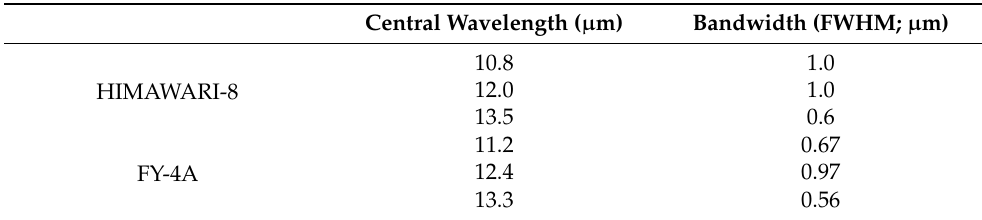
Table 1. FY-4A/AGRI and Himawari-8/AHI bands used in the CTH retrieval (FWHM: full width at